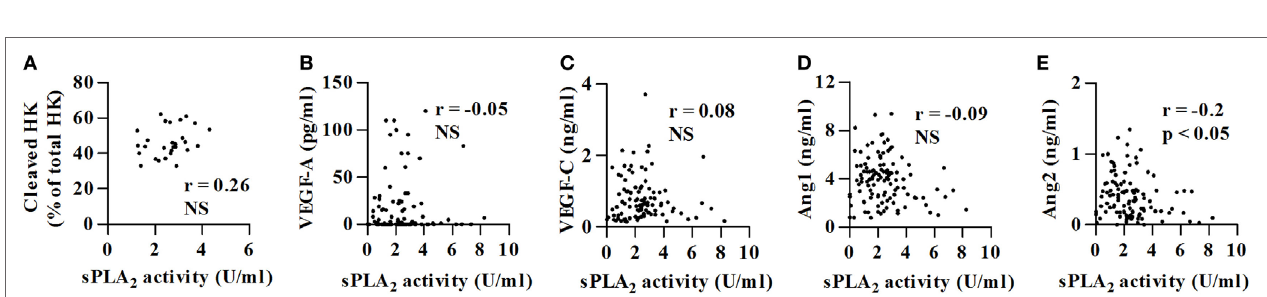
FigUre 3 | Correlations between sPLA 2 activity and cleaved HK, VEGF-A, VEGF-C, and Angs concentrations. Correlations between two variables: sPLA 2 (U/ml) and cleaved HK (a) , sPLA 2 and VEGF-A (B) , sPLA 2 and VEGF-C (c) , sPLA 2 and Ang1 (D) , and sPLA 2 and Ang2 (e) , were assessed by Spearman’s correlation analysis and reported as coefficient of correlation ( r ).